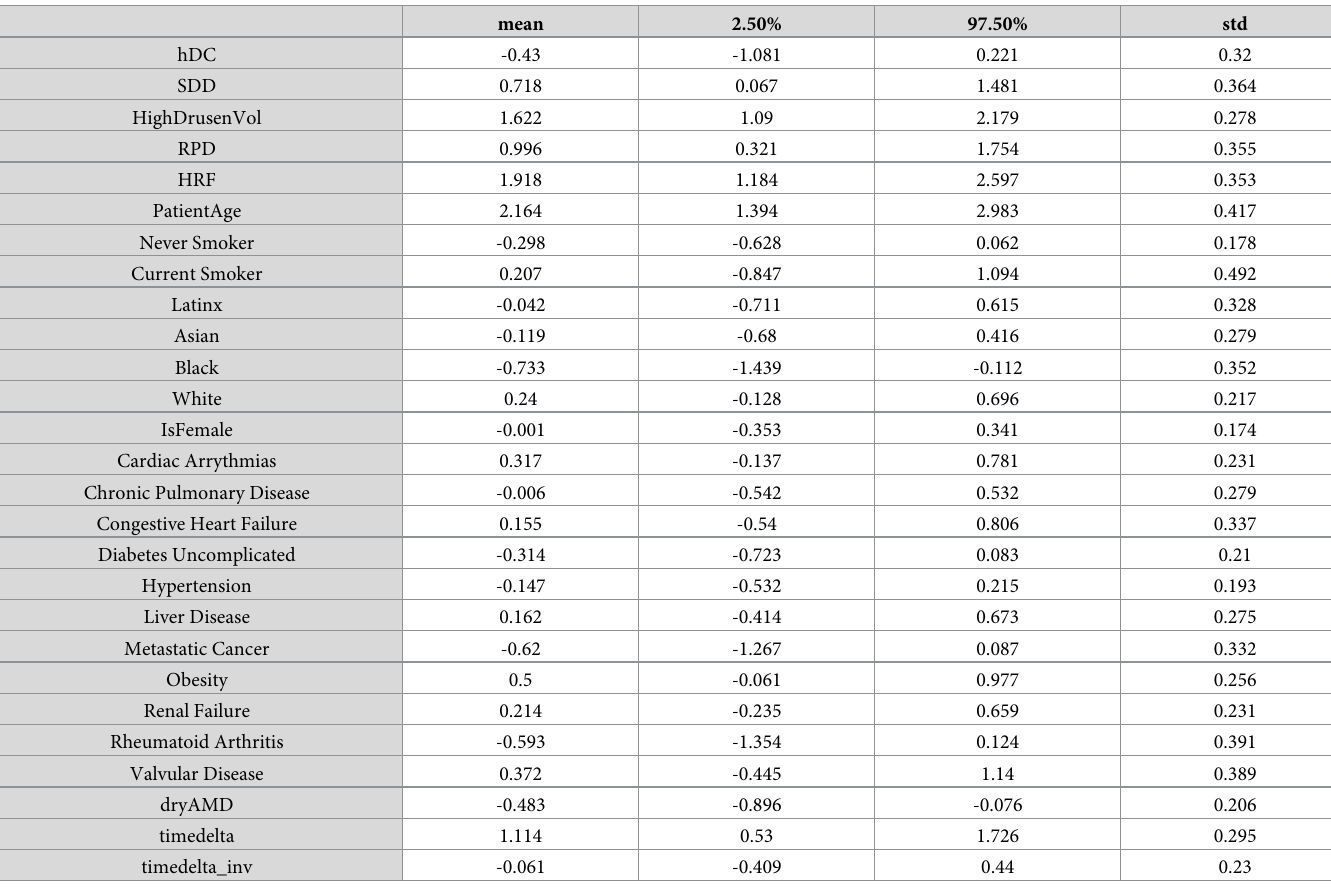
Table 3. 95% confidence intervals and standard deviation of values obtained by fitting the model to bootstrapped subsets of the cohort. Feature weights of the com- bined